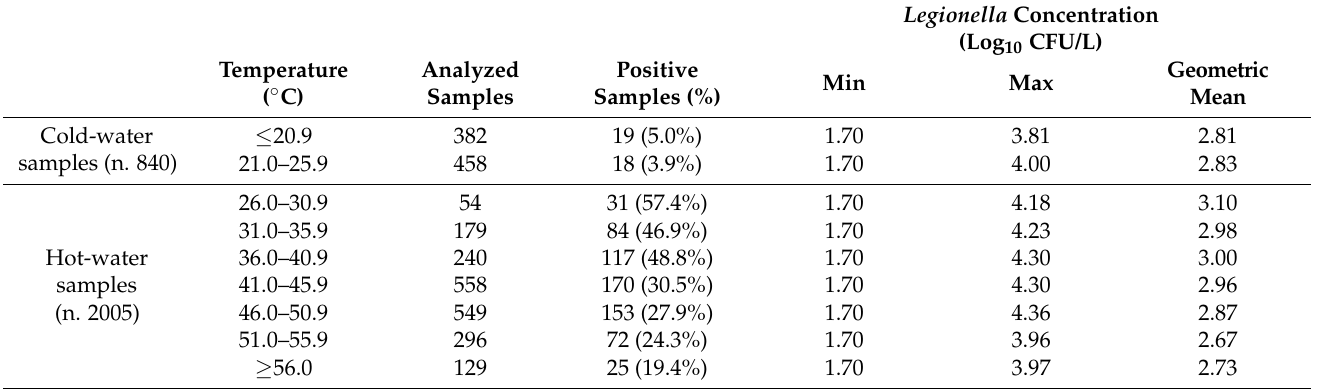
Table 3. Number of analyzed samples, number of positive samples, percentage of positive samples, minimum and maximum values, and geometric mean of Legionella concentration of positive samples for different ranges of temperature.